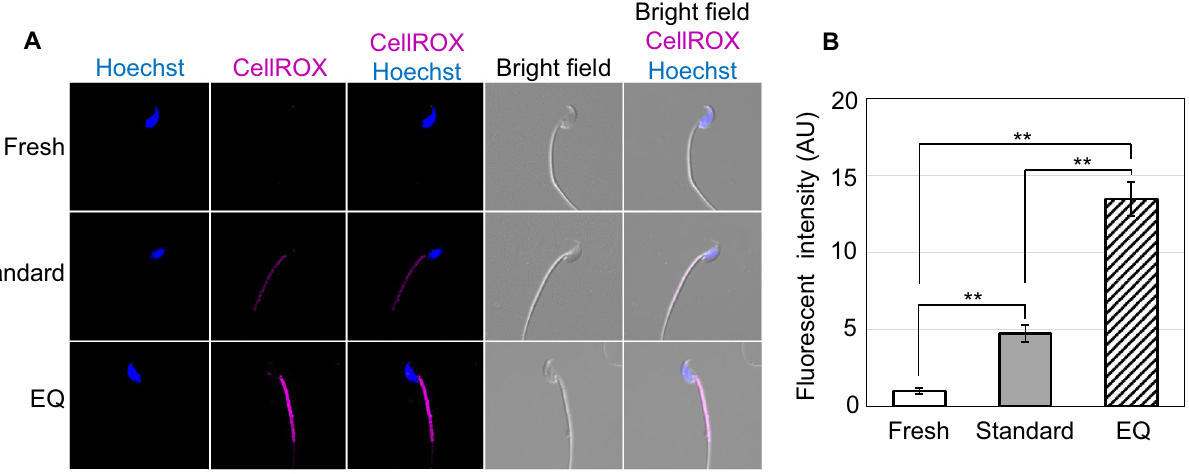
Figure 8. Visualization of oxidative stress by CellROX Deep Red staining. ( A ) Representative images of fresh and frozen–thawed spermatozoa cryopreserved by standard or EQ methods after staining with Hoechst 33,342 and CellROX Deep Red. ( B ) Relative fluorescent intensities of CellROX Deep Red signals. ** P < 0.01 between groups by Tukey–Kramer